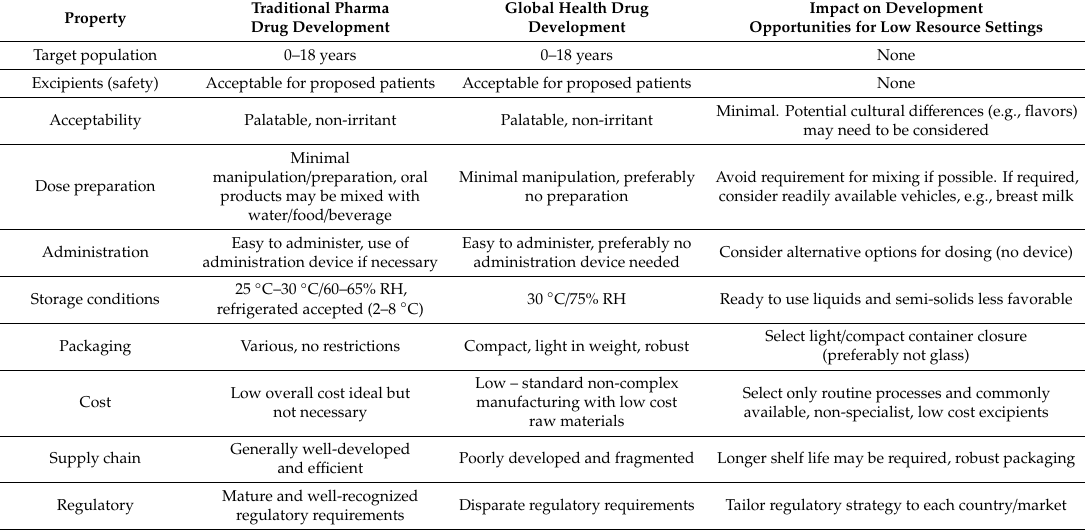
Table 1. Exemplative comparison of potential considerations for pediatric medicine, pharmaceutical development, and supply requirements for high income economies compared to low- and middle-income